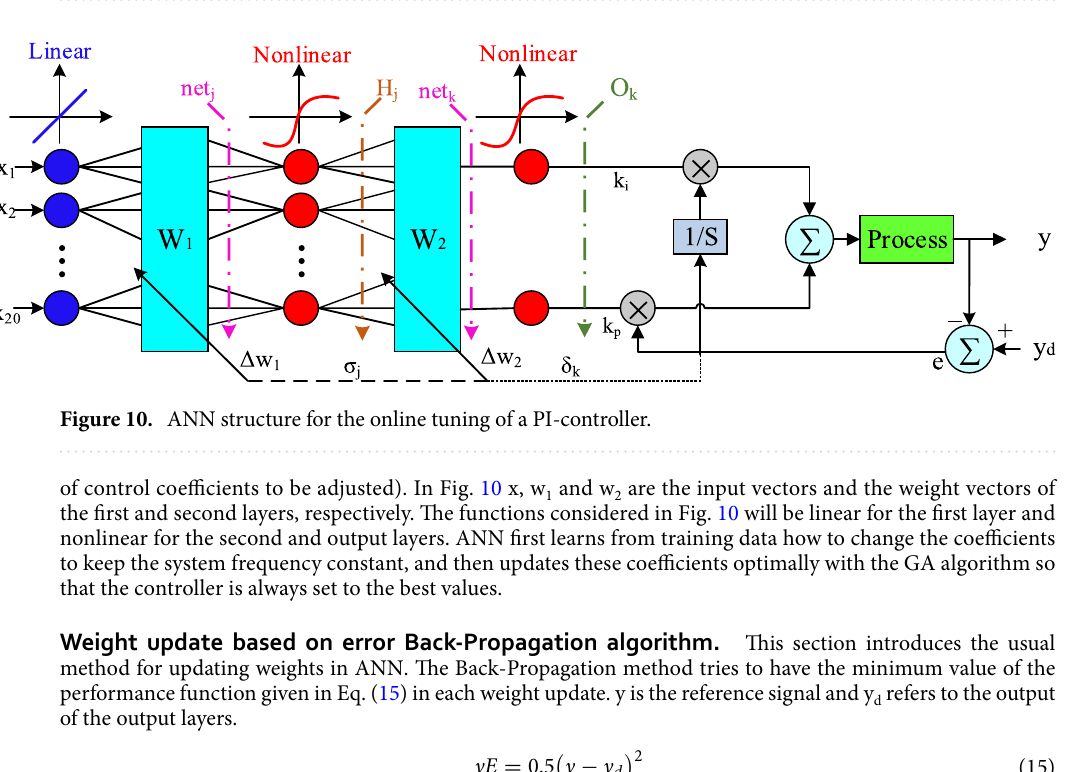
Figure 9. Proposed control structure for self-tuning PI-controller.